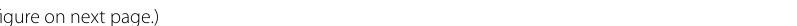
figure on next Fig. 5 NAC affects EMT via the VWF/p38 MAPK axis. A Efficiency of sh-p38 MAPK-1 and sh-p38 MAPK-2 detected by RT-qPCR. B Efficiency of sh-p38 MAPK-1 and sh-p38 MAPK-2 detected by Western blot analysis. CSE cells were transduced with NAC and oe-VWF and/or sh-p38 MAPK. C Expression of VWF and p38 MAPK, and the extent of p38 MAPK phosphorylation in CSE cells determined by Western blot analysis. D CSE cell migration detected by Transwell assay. E CSE cell invasion detected by Transwell assay. F Protein levels of E-cadherin and N-cadherin in CSE cells determined by Western blot analysis. *** p < 0.001. **** p < 0.0001. Data are shown as the mean standard deviation of three technical replicates. Data among ± multiple groups were compared by one-way ANOVA with Tukey’s post hoc